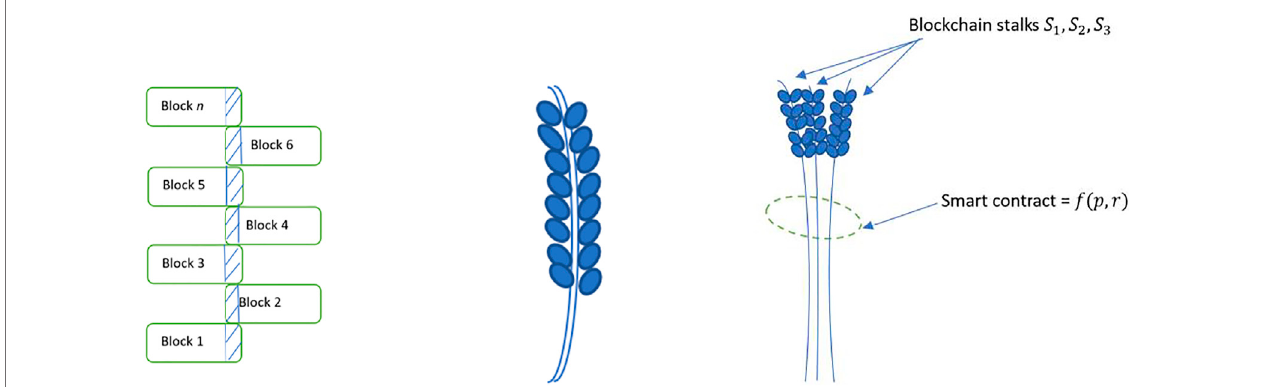
FIGURE 4 | An analogy describing stalks and blocks. Left: Blockchain as a stalk. The shaded portion represents the hash functions that link blocks to their successors and predecessors, thus forming a central spine around which transactions are linked. Middle: An individual stalk with seeds. Right: A sheaf of blockchain stalks bound by a smart contract tuned with imperfect information ( p )and irrationality ( r ).